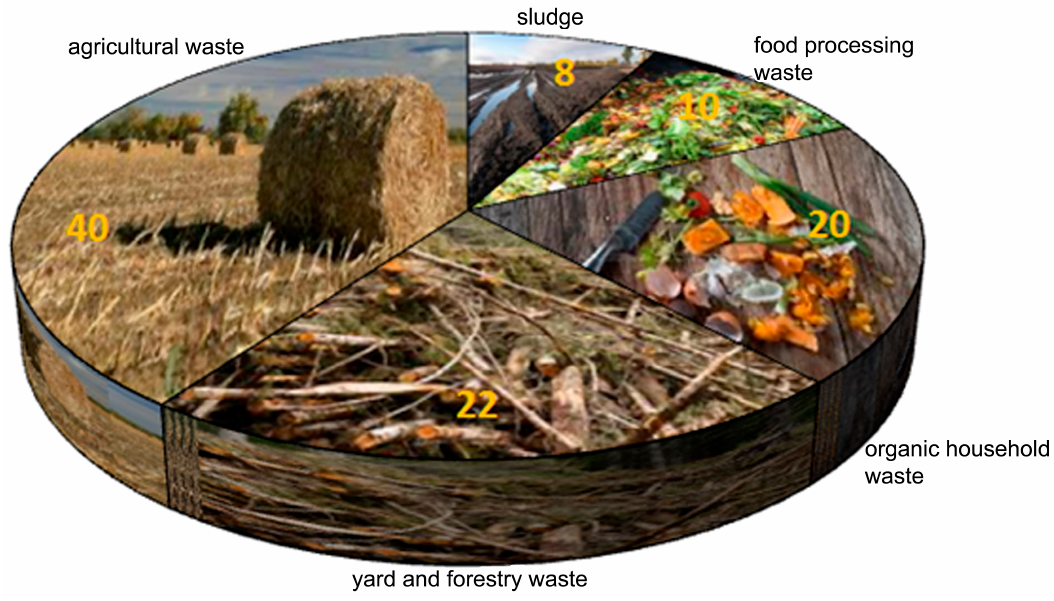
Figure 1. Annual bio-waste production in Europe.